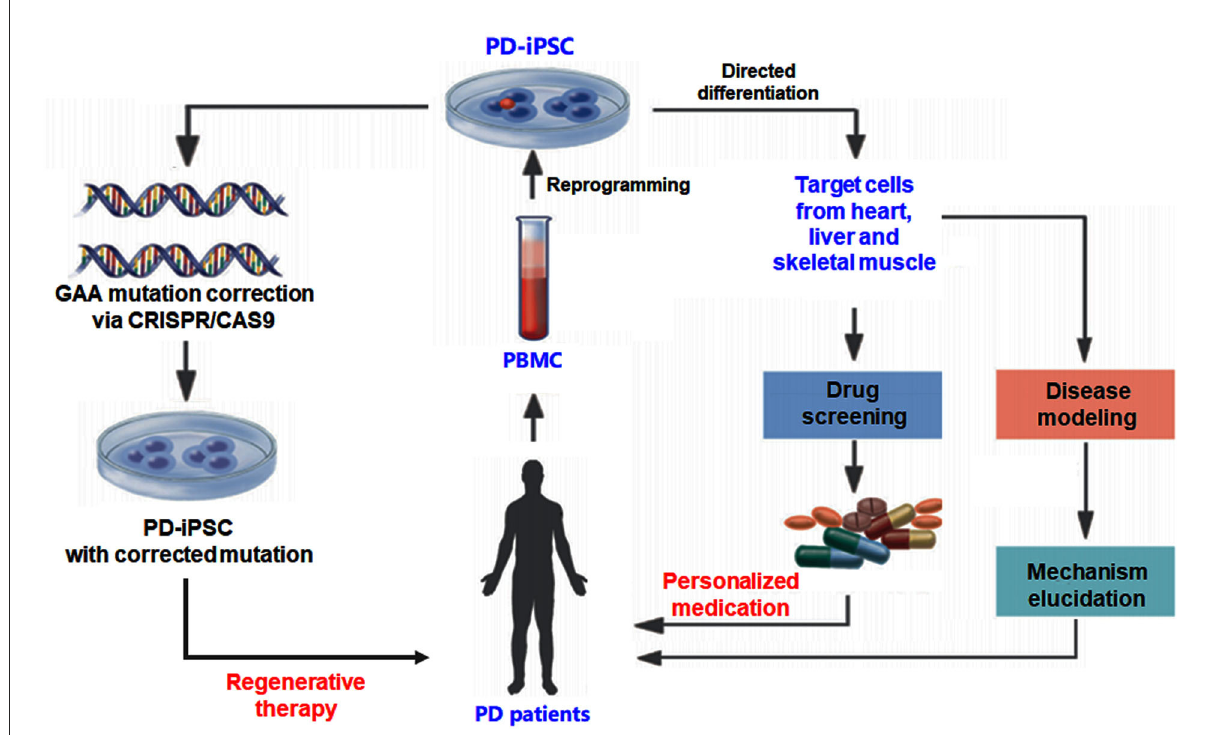
FIGURE1 Experimental strategy using human iPSC for Pompe disease (PD) study. The iPSC generated from patients with PD can be differentiated into different cell types to investigate the pathogenesis and develop drug screening for individualized treatment. Gene-editing strategies such as CRISPR-CAS9 can be used to correct disease-causing mutations to achieve gene